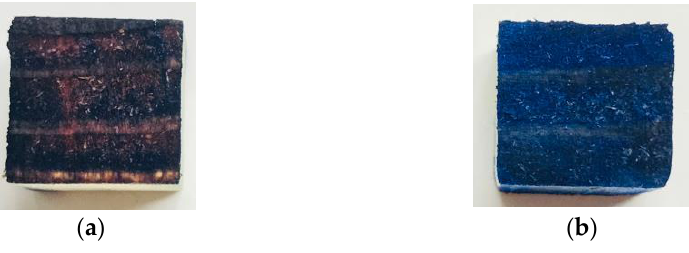
Figure 2. Photographs of interior cross-section of impregnated wood samples with CuNPs with chromium azurol staining. ( a ) Group A sample impregnated with 1 g/L CuNPs and ( b ) group B sample impregnated with 3 g/L CuNPs.